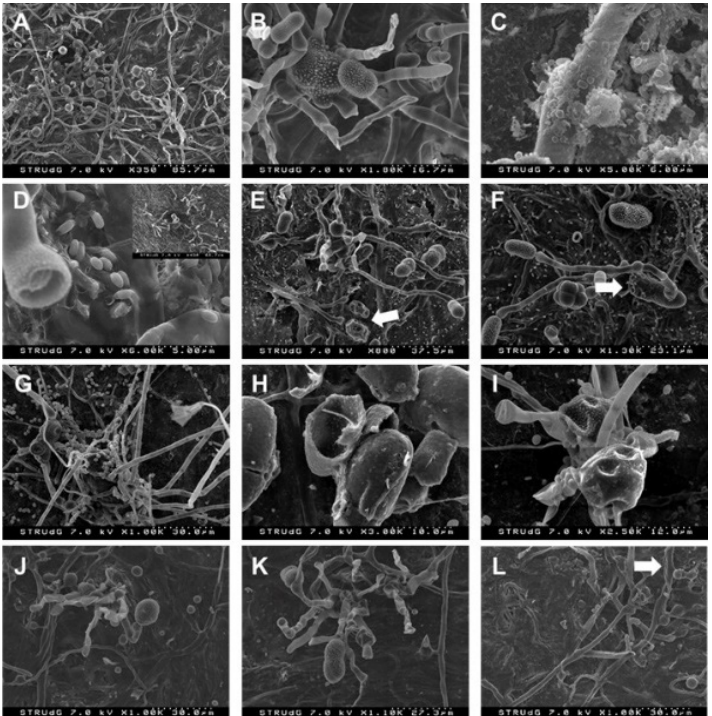
Figure 3. Colonies of Stemphylium vesicarium in non-treated control ( A , B ). Colonies of S. vesicarium and different Bacillus subtilis strains of Bs1 ( C ), Bs2 ( D ), Bs3 ( E ), and Bs4 ( F ). Colonies of S. vesicarium and Trichoderma spp. Tr1 ( G , H , I ) and Tr2 ( J , K , L ). Different biological control agents were applied 3 days after the inoculation of the S. vesicarium. Images were obtained using a scanning electron microscope.